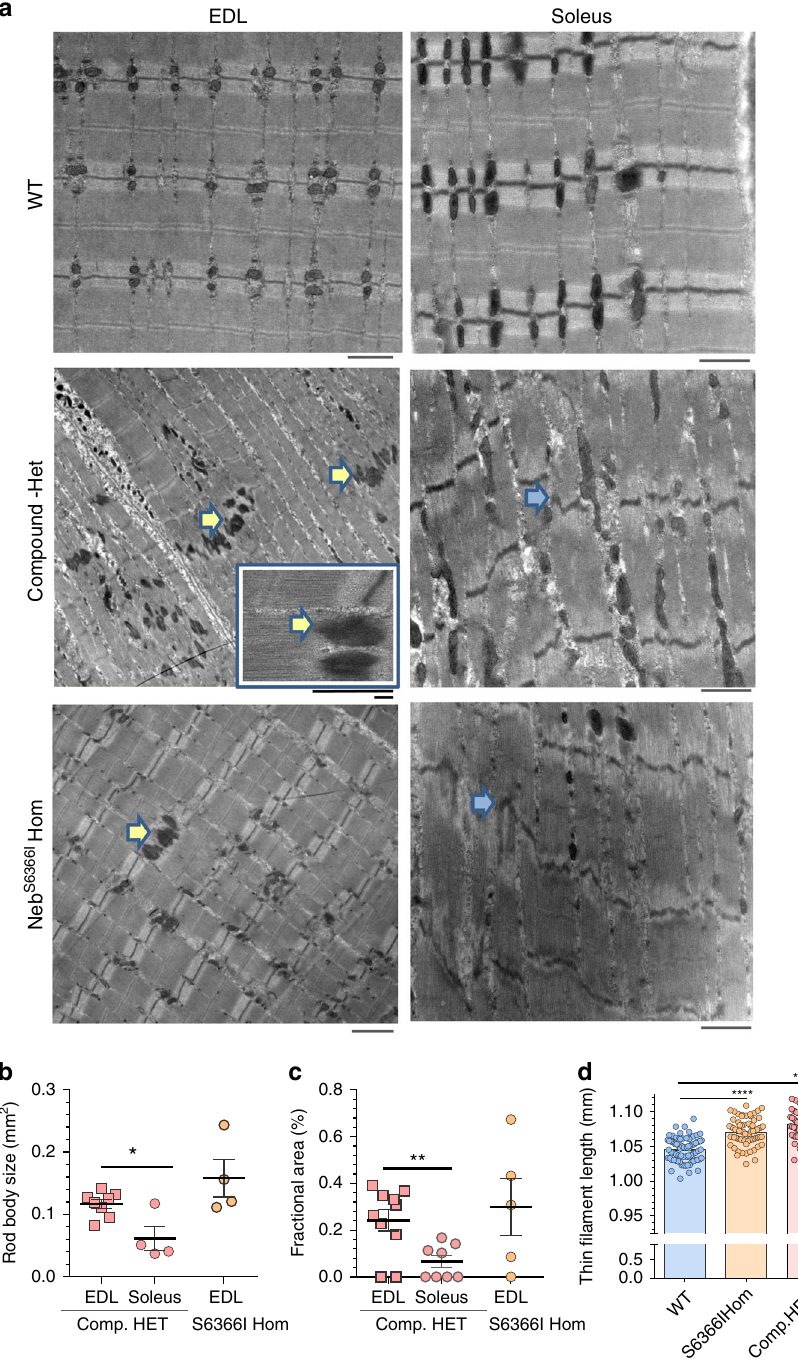
Fig. 5 Nemaline rod bodies, sarcomeric ultrastructure, and thin fi lament length. a Electron micrographs of intact EDL muscles (left) and soleus muscle (right) in WT (top), Compound-Het (middle) and Neb S6336I How (bottom). Nemaline rod bodies (yellow arrows) are found in both EDL and soleus of Compound-Het and in only EDL of Neb S6366I HOM mice. Inset in left middle panel shows enlarged rod bodies. In soleus muscle sarcomere disorganization was frequently seen in both Compound-HET and Neb S6366I HOM mice. Yellow arrows: rod bodies; blue arrows: altered/damaged Z-disks. Rod body size ( b ) and fractional area of rod bodies ( c ) in EDL and soleus. b * p = 0.03. c ** p = 0.0059. Values are means ± SEM. Four mice per genotype were used with ~5 fi bers per muscle examined. The mean value for each mouse is plotted. d Thin fi lament lengths are slightly but signi fi cantly longer in Compound Het and Neb S6366I Hom EDL muscle. Measurements made in SL range: 2.5 – 3.0 µ m. (See Supplementary Fig. 4 for images and additional data, including con fi rmations by super-resolution optical microscopy.) b – d Ordinary one-way ANOVA without matching or paring. A posthoc multiple testing comparison with multiple testing correction (Tukey) was performed. d **** p < 0.0001. n(WT) = 81 measurements from 18 fi bers from 6 mice; n (Hom) = 71 measurements from 18 fi bers from 6 mice; n (Compound HET) = 103 measurements from 18 fi bers from 6 mice. Horizontal lines are mean ± SEM. Source data are provided as a Source Data fi